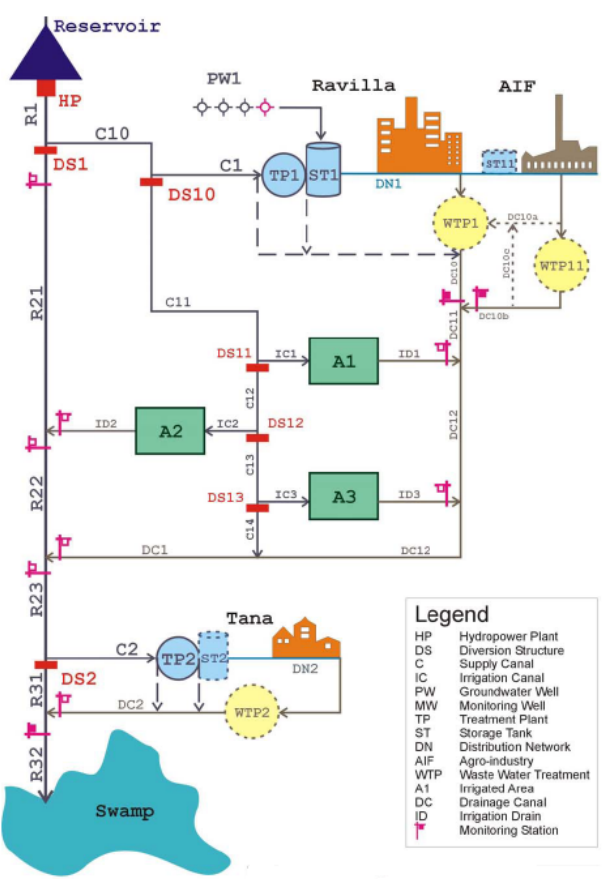
Fig. 2. Scheme of the Ra Figure 2: Scheme of the Ra Basin